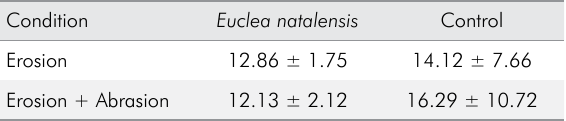
Table 1. Wear (µm) of the enamel (mean ± SD), with or without application of the gel, under two experimental conditions.